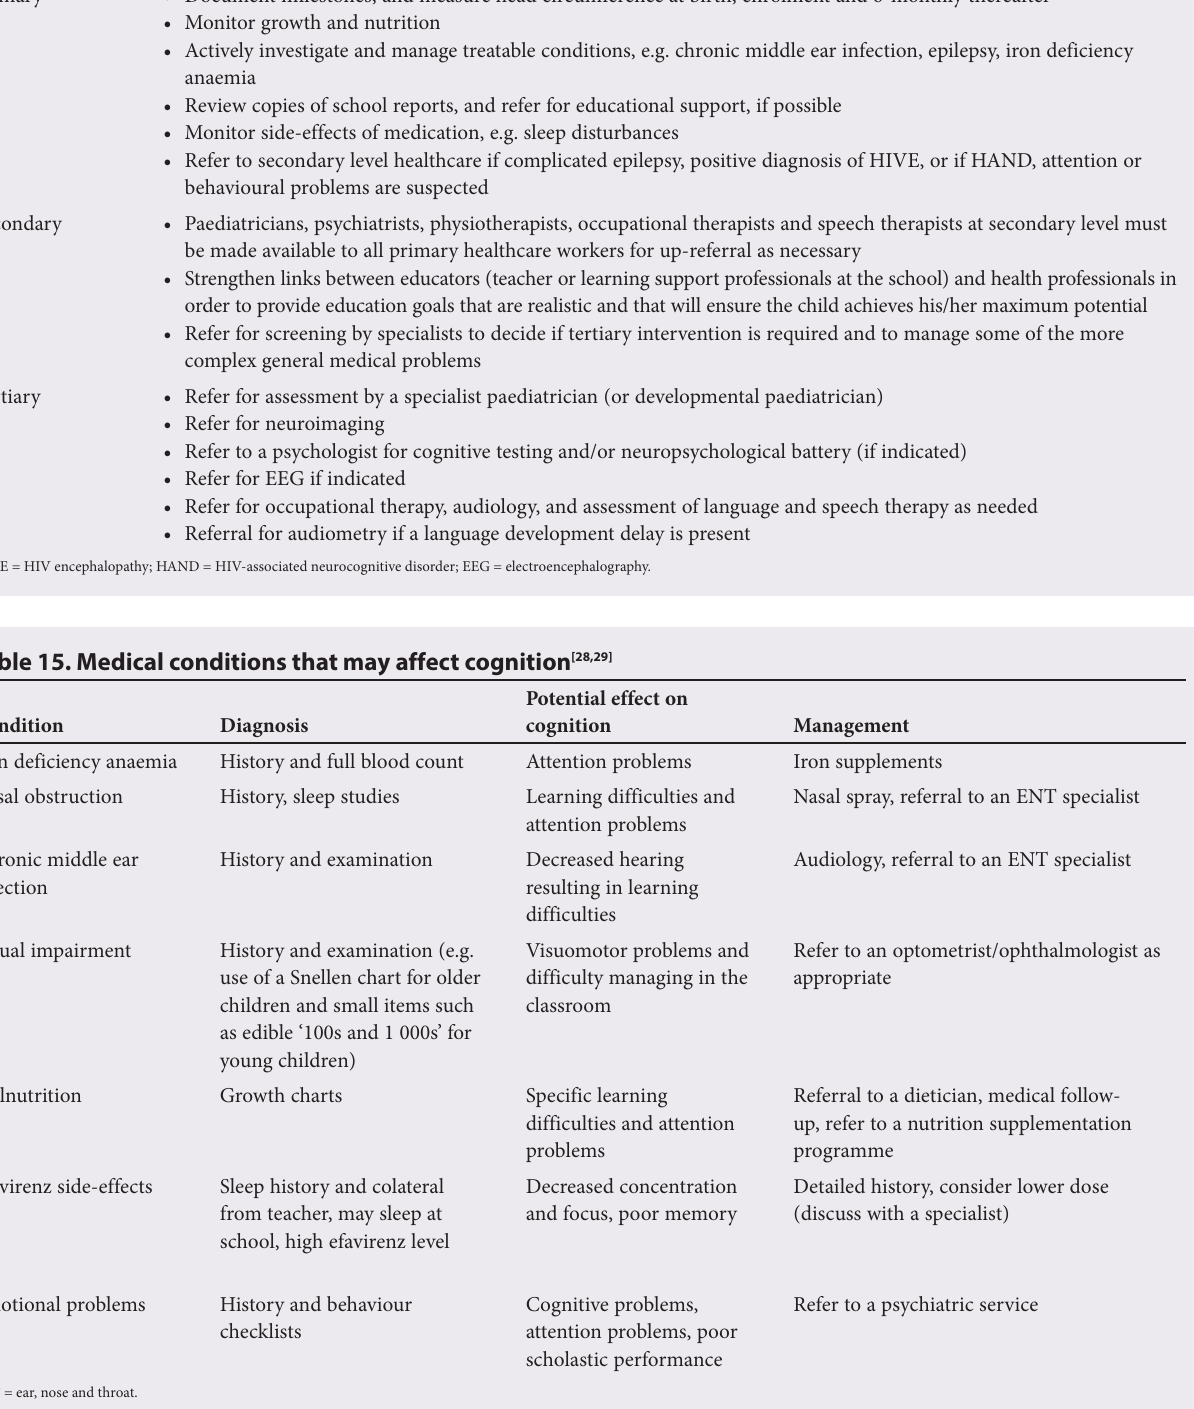
Table 14. Management of HIV-positive children at primary, secondary and tertiary care levels Primary